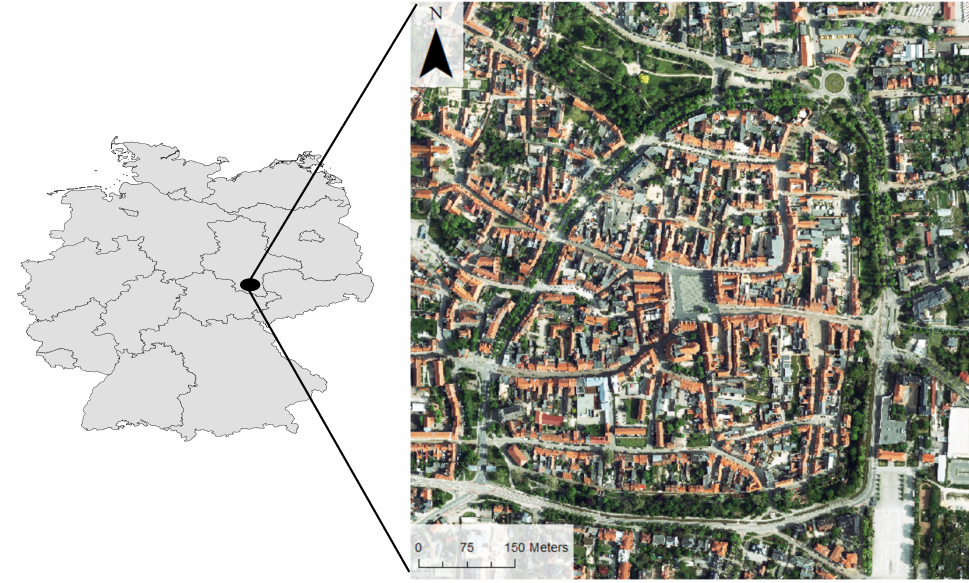
Figure 1. Orthophoto of the study area (right part) and the location within Germany.